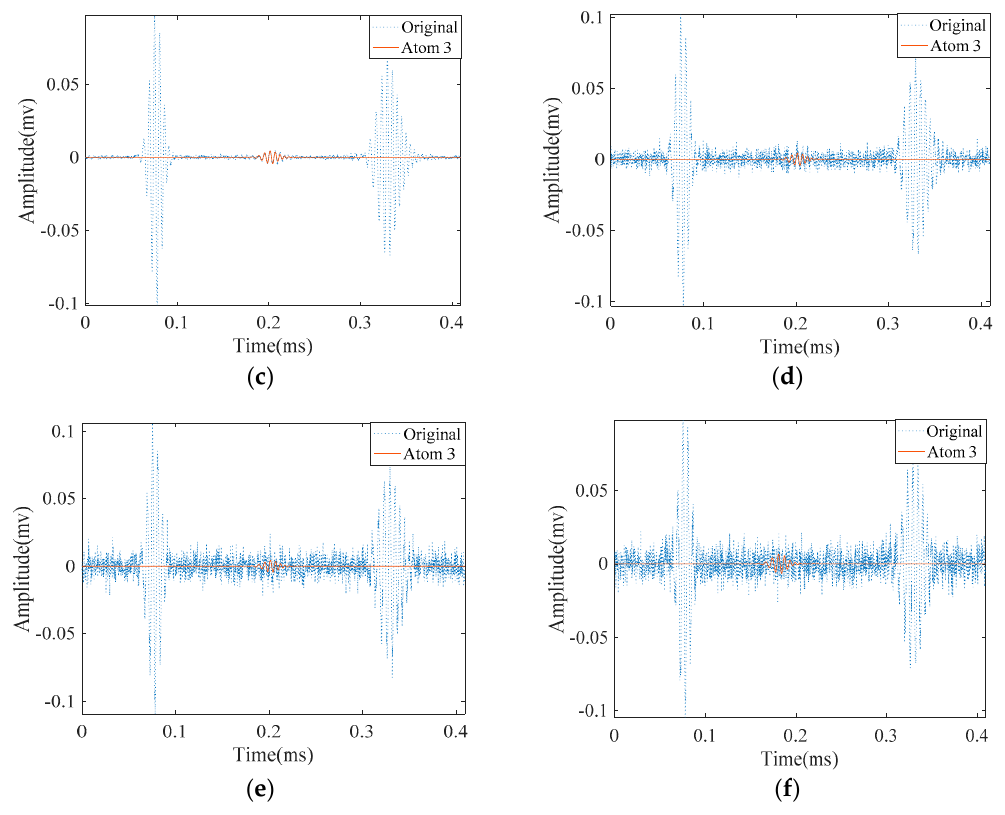
Figure 9. Detection of the small crack in the presence of noise with different signal to noise ratios (SNRs) with Sparse Representation with Dispersion Based Matching Pursuit (SDMP): ( a ) the original signal; ( b ) the approximation of crack reflected signal without noise; and with added noise that has: ( c ) SNR = 23.8 dB; ( d ) SNR = 9.8 dB; ( e ) SNR = 6.8 dB; and ( f ) SNR = 5.8 dB.